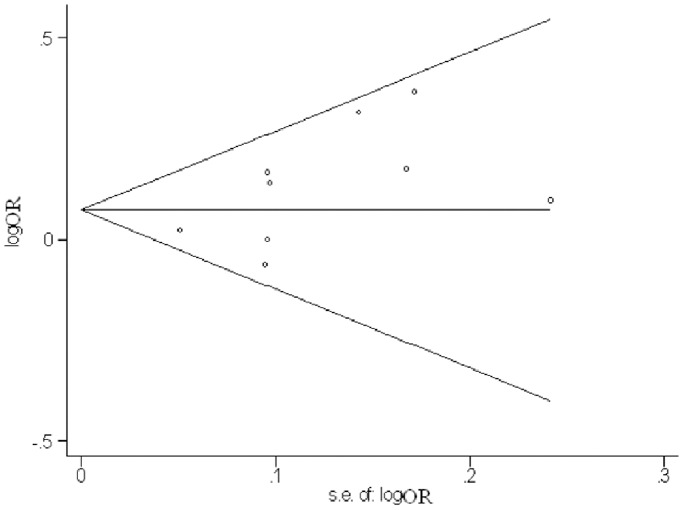
Funnel plot for studies showing the association between hypertension and the CYP4A11 T8590C polymorphism using the additive model.The vertical and horizontal axes correspond to the odds ratios and confidence limits. OR, odds ratio; s.e., standard error.